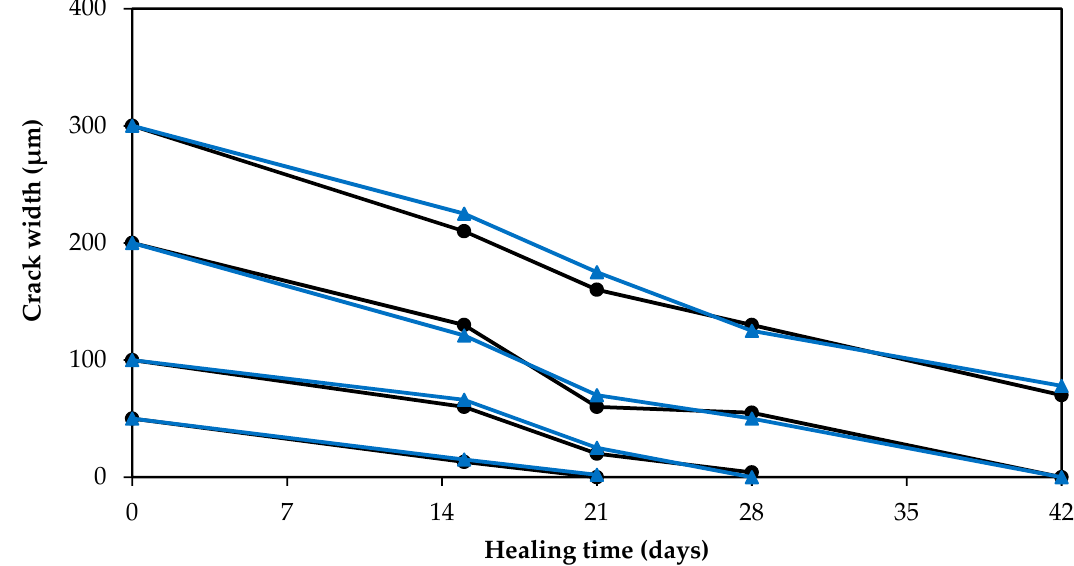
Figure 7. GA–ANN model predictions of crack self-healing (reduction in crack width) of cementitious materials versus corresponding experimentally measured results.